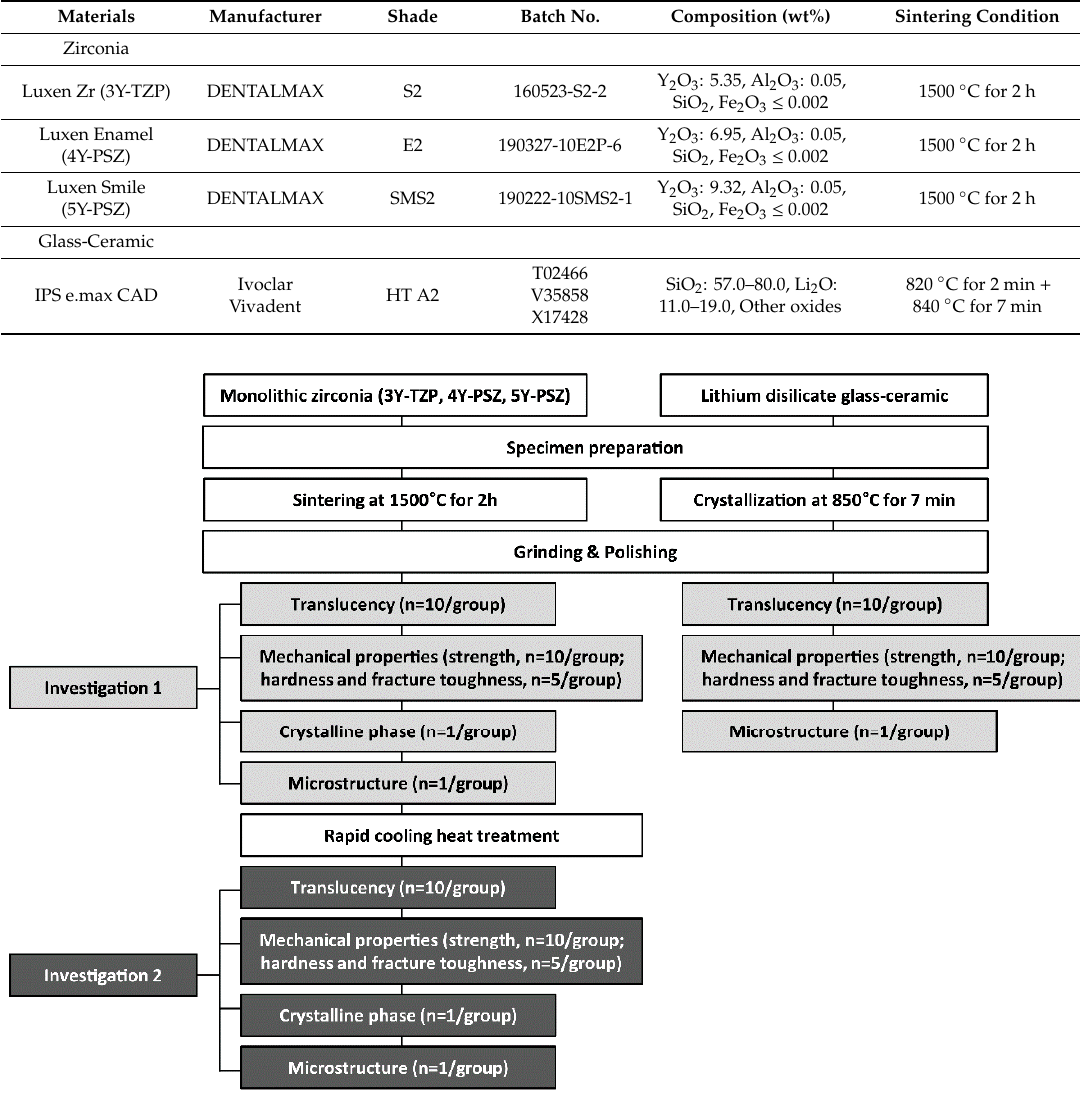
Table 1. Properties of materials used in this study.